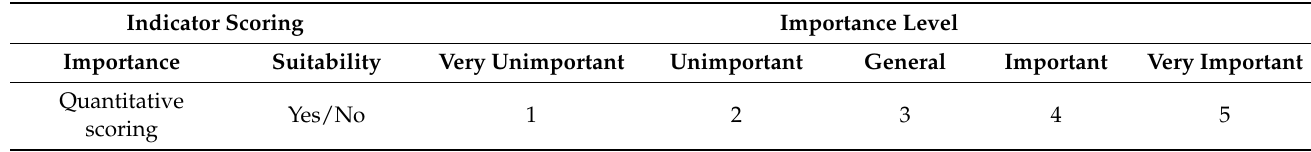
Table A3. Quantitative criteria for the importance of indicators.